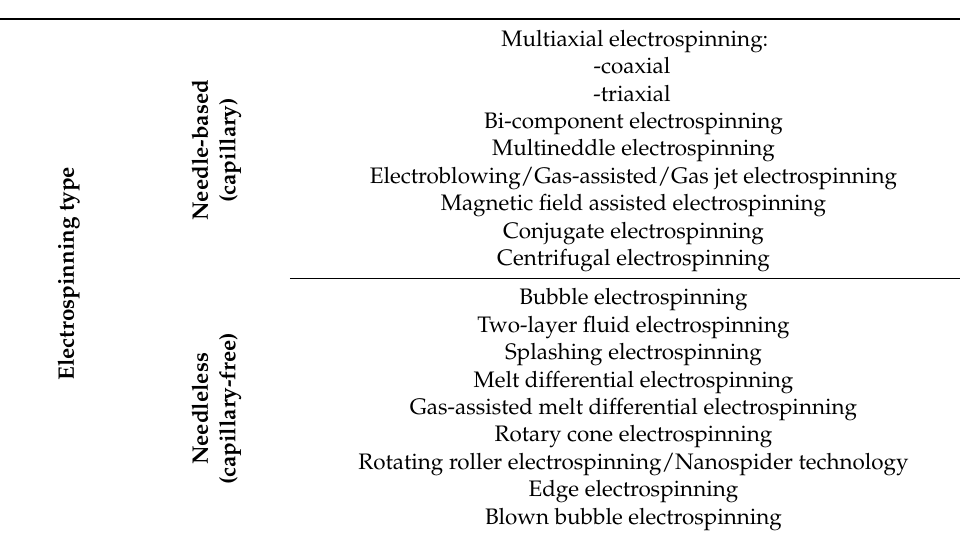
Table 2. Electrospinning